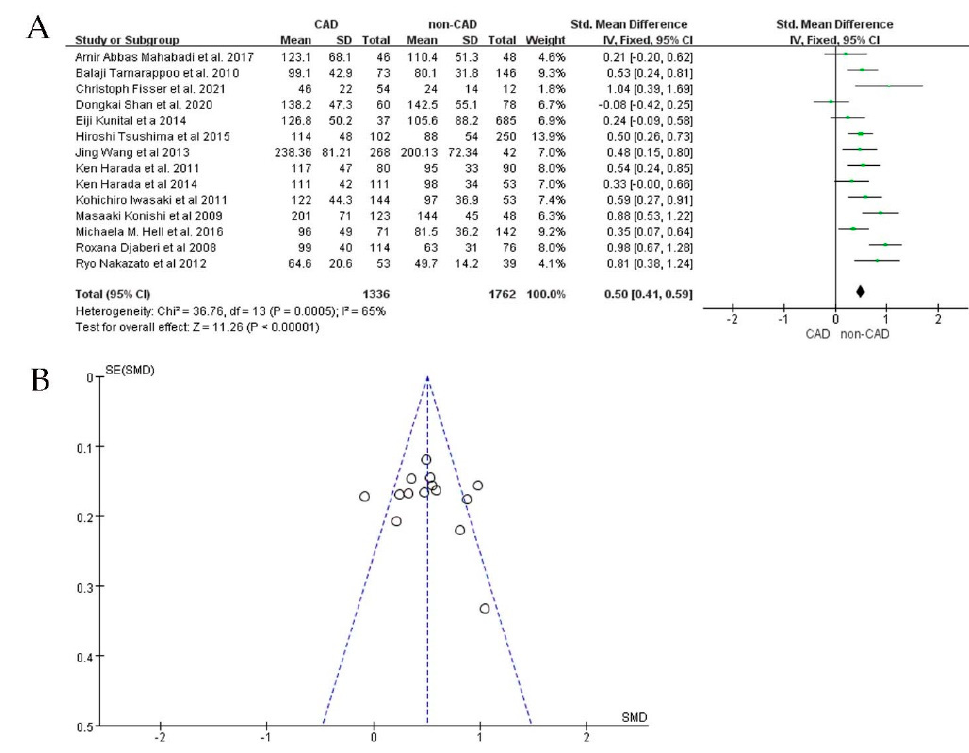
Figure 2. SMD by EAT volume between CAD patients and non − CAD patients. ( A ): Forest plot; ( B ): funnel plot.